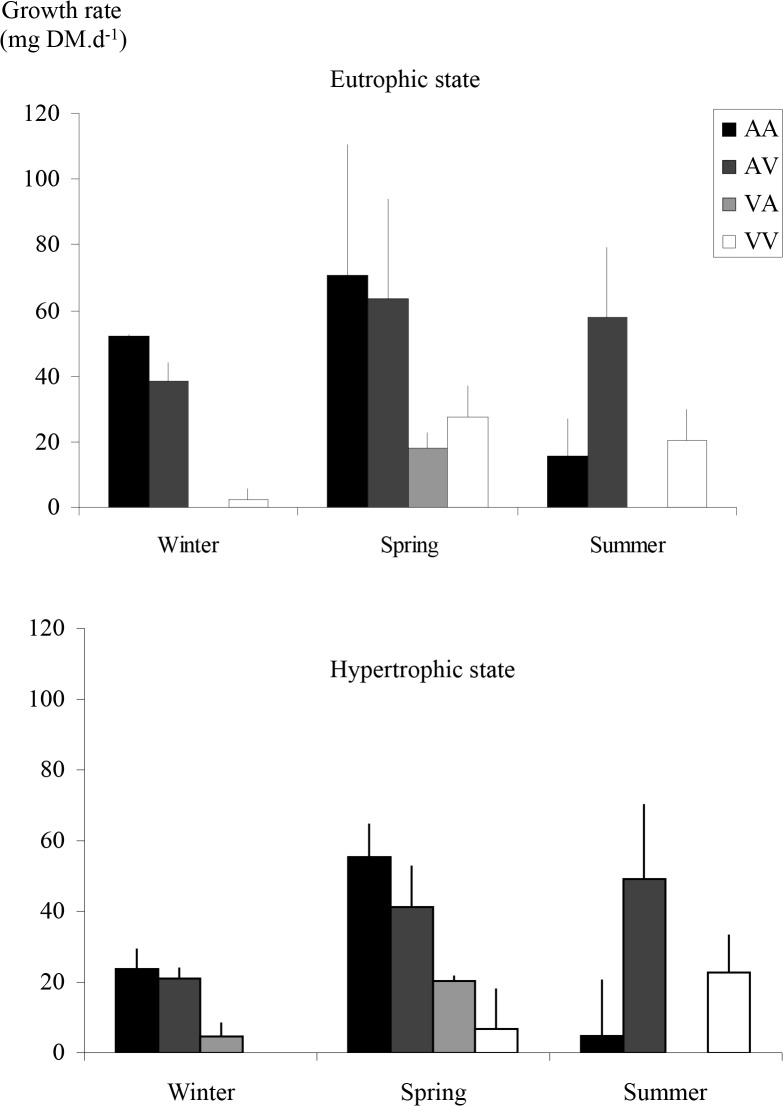
Plant growth rate.Plant growth rate (in mg of plant dry mass per day) under eutrophic and hypertrophic conditions, for all the possible combinations of water and subpopulation and during the winter, spring and summer experiments. In the legend, AA, AV, VA, VV include the information on the treatment, the first letter refers to the type of water and the second one to the subpopulation (e.g. AV means Alsatian water and Vosgian subpopulation).